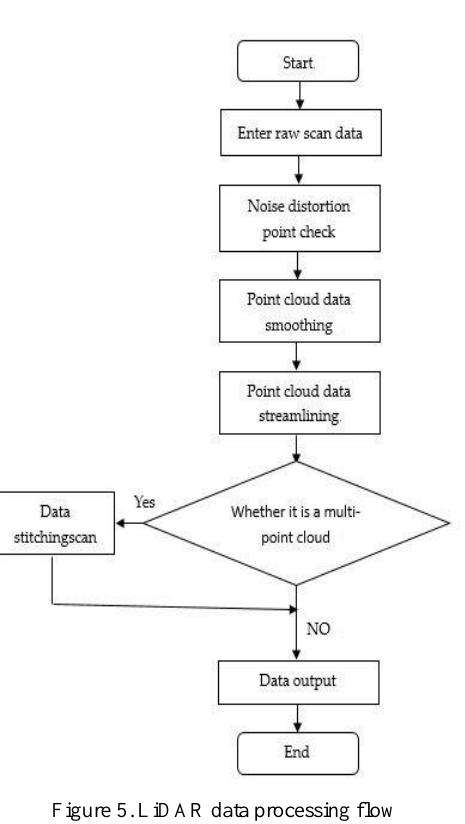
Figure 5. LiDAR data processing flow